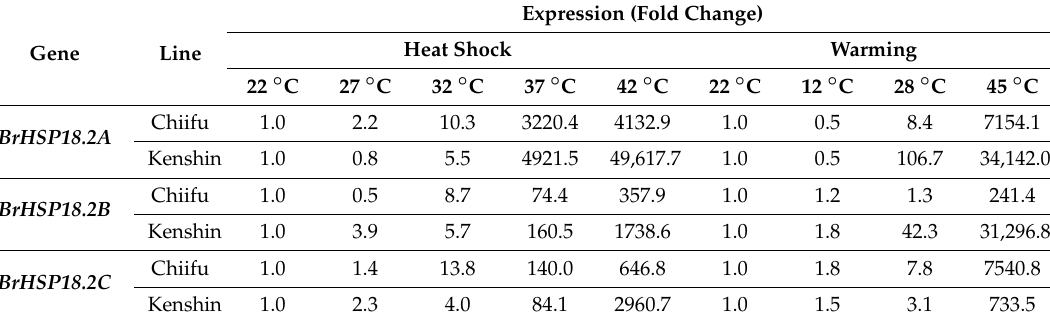
Table 5. Expression of BrHSP18.2 family genes in Chiifu and Kenshin under various temperature conditions. Expression level (fold change) was calculated based on qRT-PCR values of three